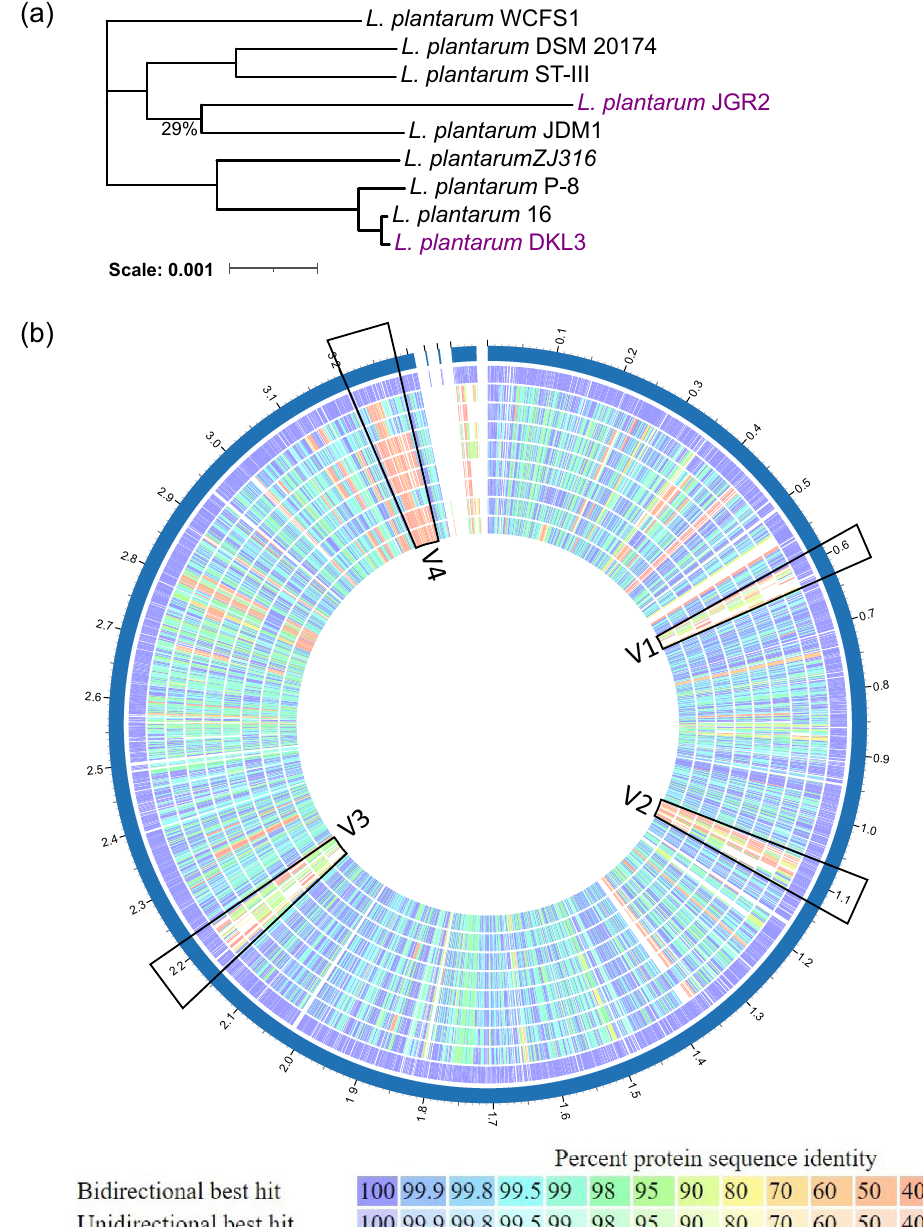
Figure 1. Genome and proteome comparison of L. plantarum DKL2 and JGR2 with the reference strains. ( a ) Core genome-based phylogeny performed by neighbour-joining method and illustrated using iTOL (v6, https:// itol. embl. de/). Only the bootstrap values < 100% are shown in figure. ( b ) Proteome comparison using PATRIC (v 3.6.12, https:// www. patri cbrc. org/) showing the genomic regions (V1-V4) encoding the variable proteins. List of tracks, from outside to inside: L. plantarum WCFS1, ST-III, JDM1, P-8, 16, ZJ316, DSM 20174, DKL3, and